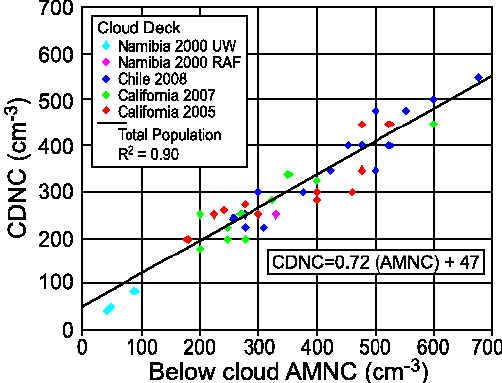
Figure 3. Linear regression of cloud drop number concentration (CDNC) onto Fig. 3. Linear regression of cloud drop number concentration accumulation mode number concentration (AMNC). Data are primarily from the (CDNC) onto accumulation mode number concentration (AMNC). California and Chilean cloud decks but a few points from the Namibian deck are Data are primarily from the California and Chilean cloud decks but included as well. a few points from the Namibian deck are included as